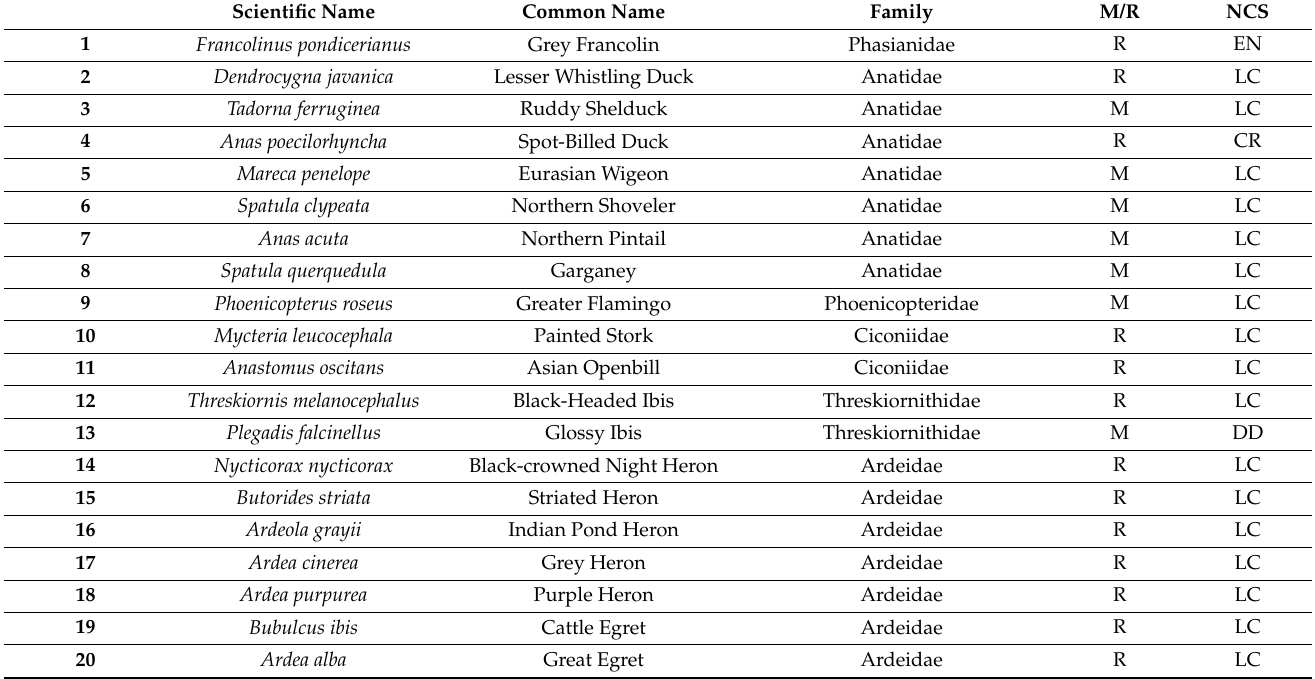
Table A1. Status of avifauna in the Sarasalai mangrove